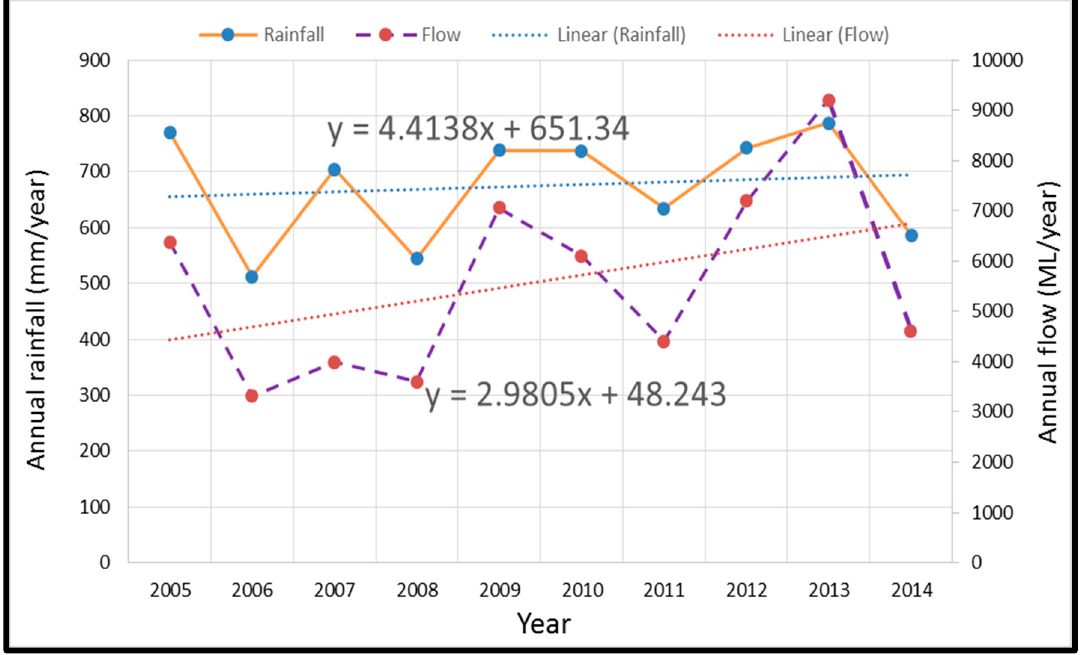
Figure 4. Rainfall and flow trends within the modelling period for the Myponga catchment.